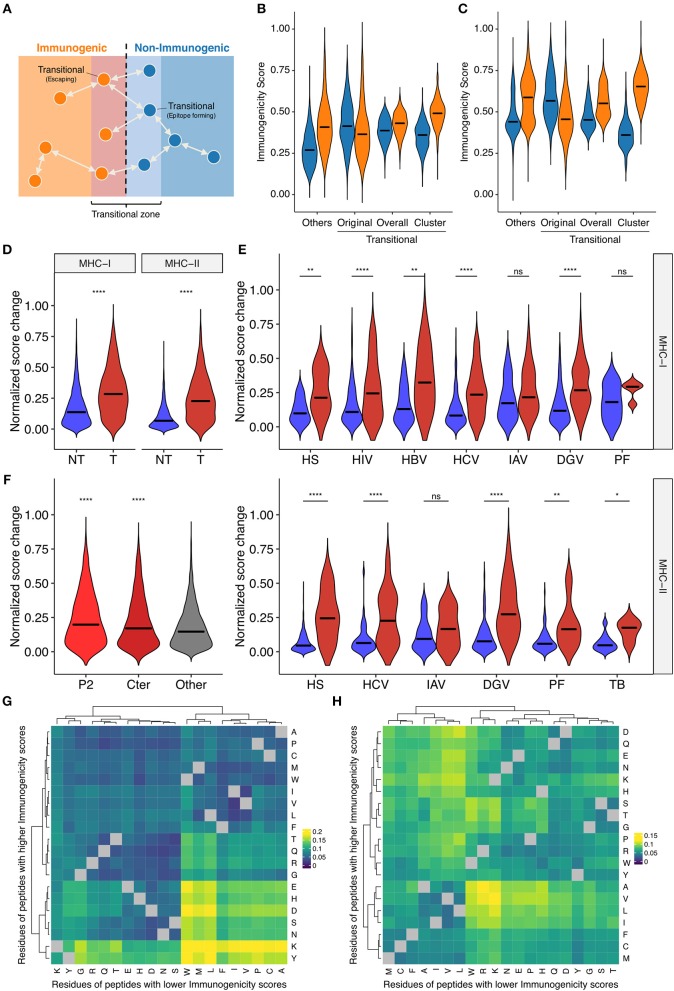
Systematic characterization of the impacts of single amino acid mutations on immunogenicity in sequence space. (A) Schematic of the concept of immune transition in sequence space. We termed the change in immunogenicity between neighbors, i.e., single-aa mutants, as “immune transition,” and defined peptides with evidence of immune transition as “transitional.” (B,C) Immunogenicity scores among (B) MHC-I- and (C) MHC-II-restricted transitional peptides, i.e., peptides with at least one neighbor of opposite immunogenicity annotation in our dataset. We identified 1,360 and 976 transitional peptides for MHC-I and MHC-II, respectively. We expanded their neighbor networks by computing immunogenicity scores for 232,723 and 292,437 all possible single-aa mutants of transitional MHC-I- and MHC-II-restricted peptides, respectively. Original, original immunogenicity scores; Overall, mean immunogenicity scores of all neighbors. Cluster, mean immunogenicity scores of neighbors assigned to the cluster containing the parent peptide. Others, original immunogenicity scores for peptides with no evidence of immune transition (shown for comparison). Orange and blue denote immunogenic and non-immunogenic peptides, respectively. (D–F) Immunogenicity score dynamics among observed neighbor pairs. We identified 6,179 and 3,076 single-aa mutated peptide pairs for MHC-I and MHC-II, respectively. (D) Score dynamics for all possible peptide pairs, regardless of their origins. (E) Score dynamics for pairs of peptides derived from the same organism. Blue and red denote non-transitional and transitional pairs, respectively. (F) Score dynamics of MHC-I peptide pairs stratified by their mutated positions. Cter, C-terminal residue. (G,H) Heatmap clustering analysis of immunogenicity score dynamics by mutating residue pairs. We generated 2,580,890 and 3,101,092 neighbor pairs from 232,723 to 292,437 all possible single-aa mutants of 1,360 and 976 transitional MHC-I- and MHC-II-restricted peptides, respectively. Color represents median normalized score changes. Gray indicates unobserved residue pairs. In (D–F), ns, not significant; *P < 0.05; **P < 0.01; ****P < 0.0001.